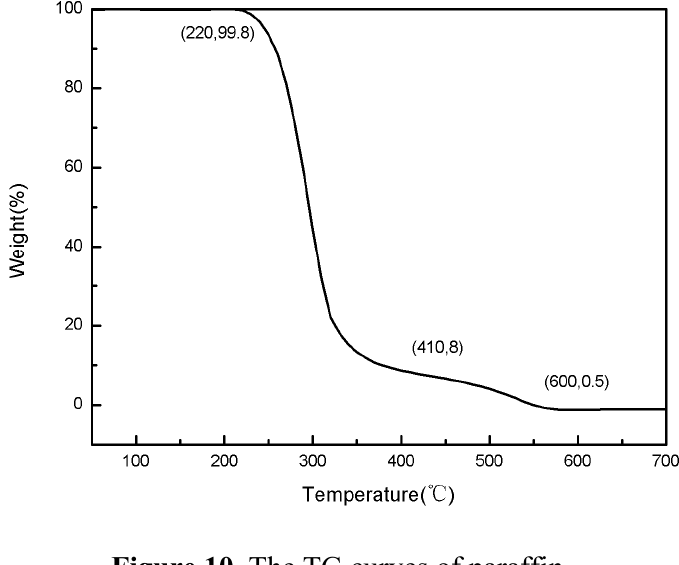
Figure 10. The TG curves of paraffin.